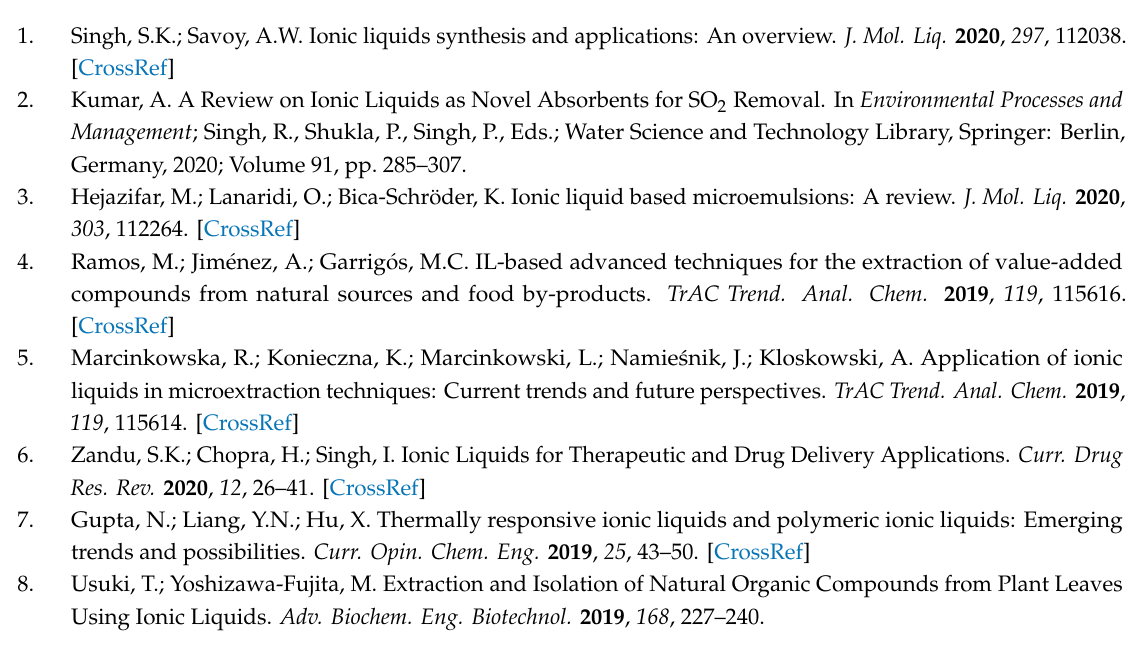
Table S1: Infrared vibrational frequencies ( ω in cm − 1 ) and intensities (I in km / mol) of the two ions EMI and TfO (calculated by the B3LYP functional and the 6-31G** basis set in a vacuum) and of the EMI–TfO ionic couple (calculated at the ω B97X-D level of theory with the 6-31G** basis set and including a polar